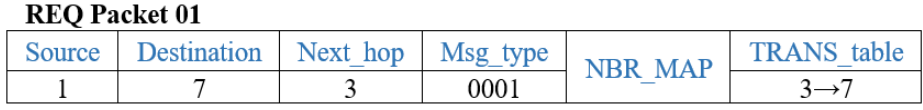
Figure 10. Request packet of node N 1 . Table 4. Transmission table of N 1 and its neighbors after first REQ message.